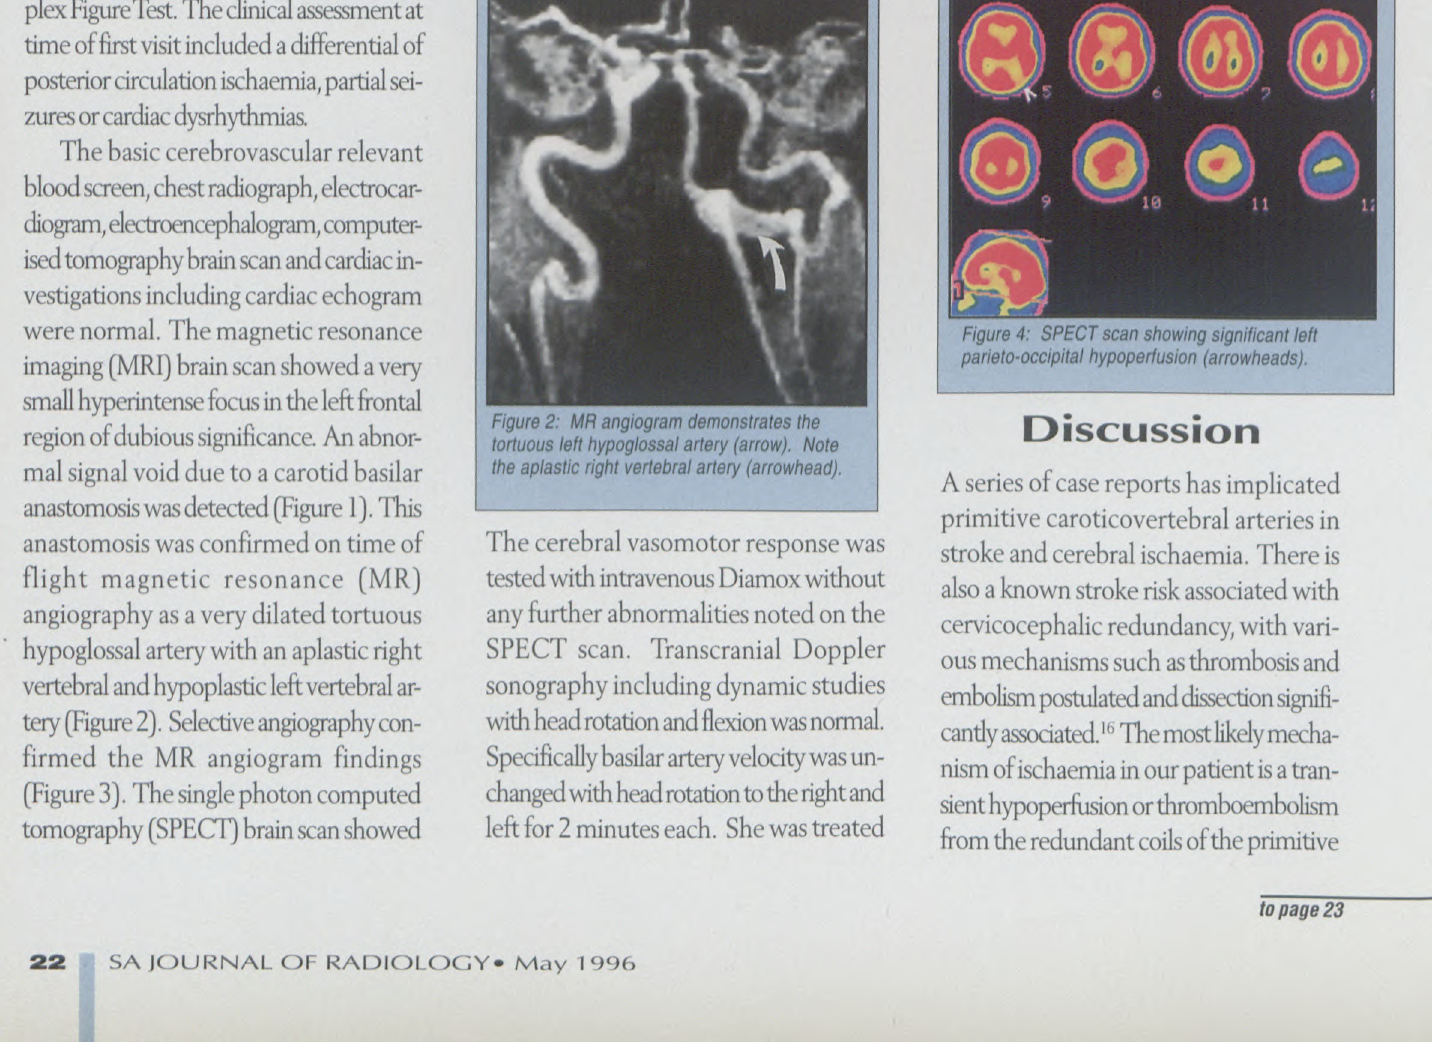
Figure 1: A T2 weighted axial scan demonstrates a signal void from the carotid basilar anastomosis (arrow).